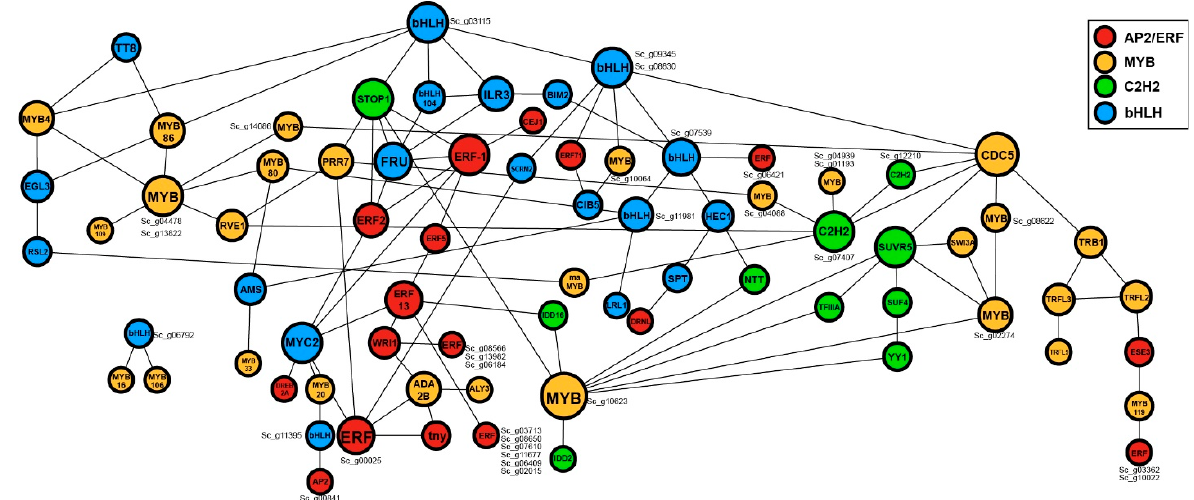
Figure 5. Protein-protein interaction networks of four overrepresented transcription factor families (AP2/ERF, MYB, bHLH, and C2H2) in S. caninervis . Different node colors indicate different TF family genes, and each edge indicates an interaction between two proteins. Red, yellow, green, and blue nodes mark AP2/ERF, MYB, C2H2, and bHLH TF families, respectively. The number of interacting genes was indicated by cycle size.